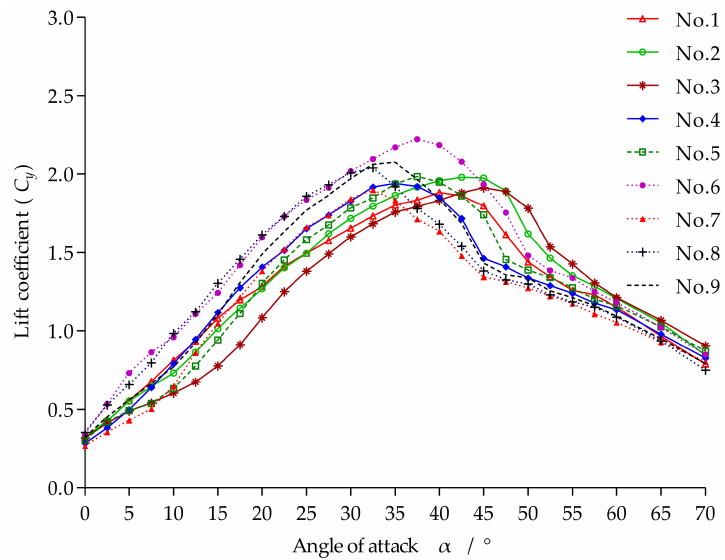
Figure 8. C y versus the angle of attack α for the nine otter board models.